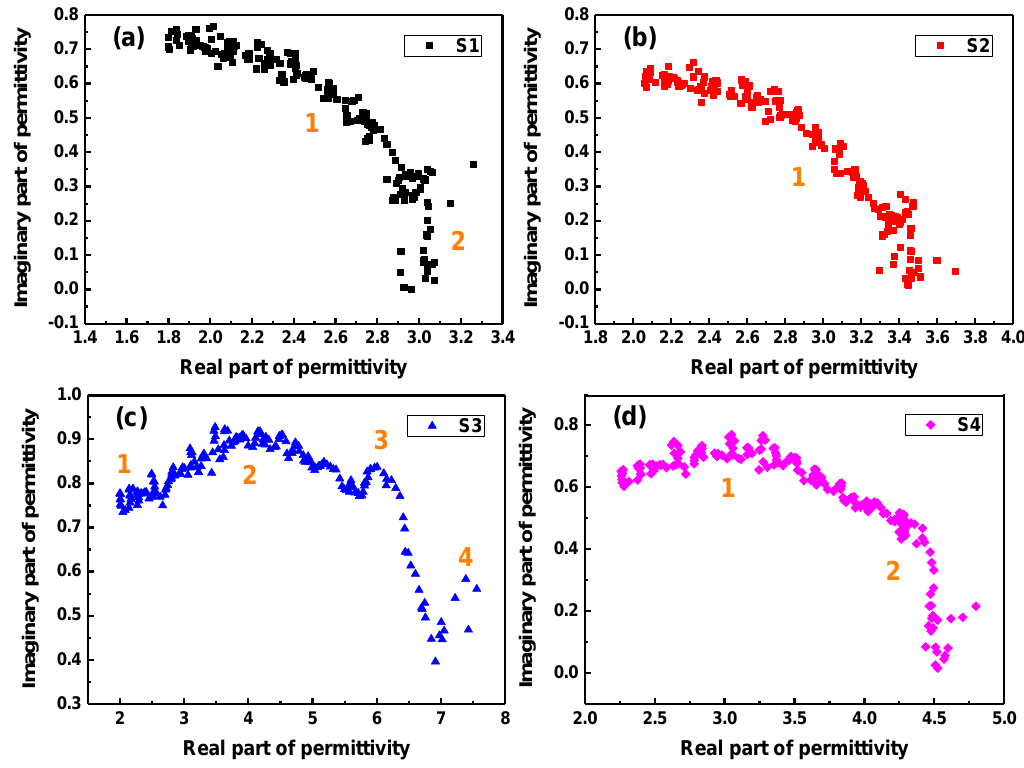
(cid:48) − ε (cid:48)(cid:48) for S1, S2, S3, and S4 at the thickness of 4 Figure 11. Plots of -    for S1, S2, S3, and S4 at the thickness of 4 mm. Figure 11. Plots of ε Figure 11. Plots of -    for S1, S2, S3, and S4 at the thickness of 4 mm.